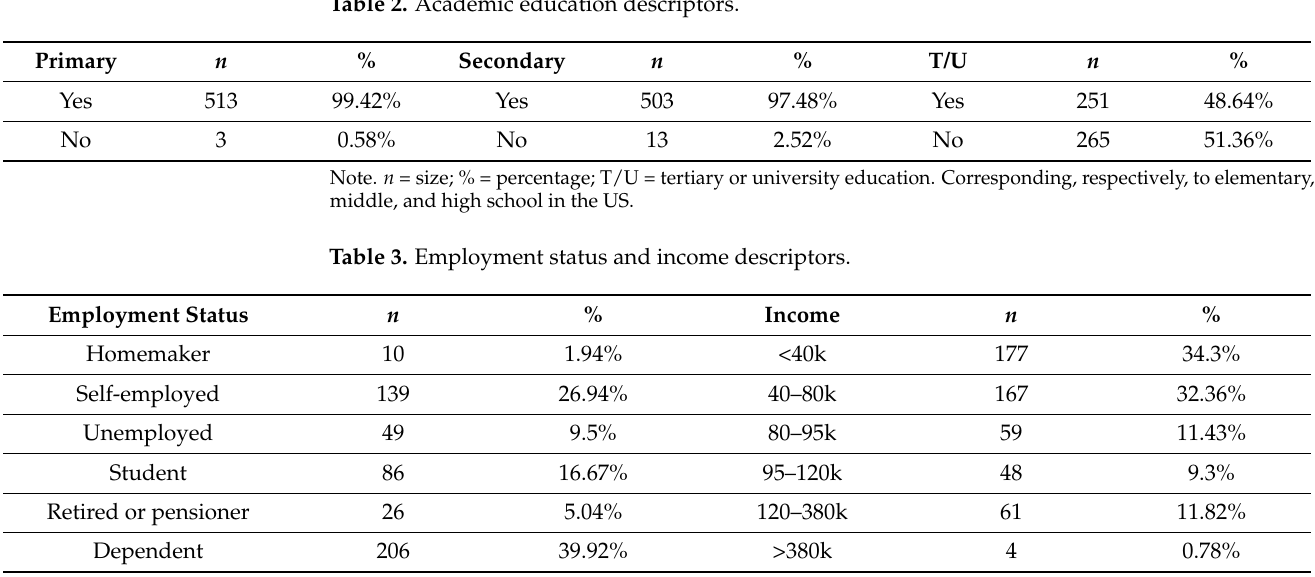
Table 2. Academic education descriptors.